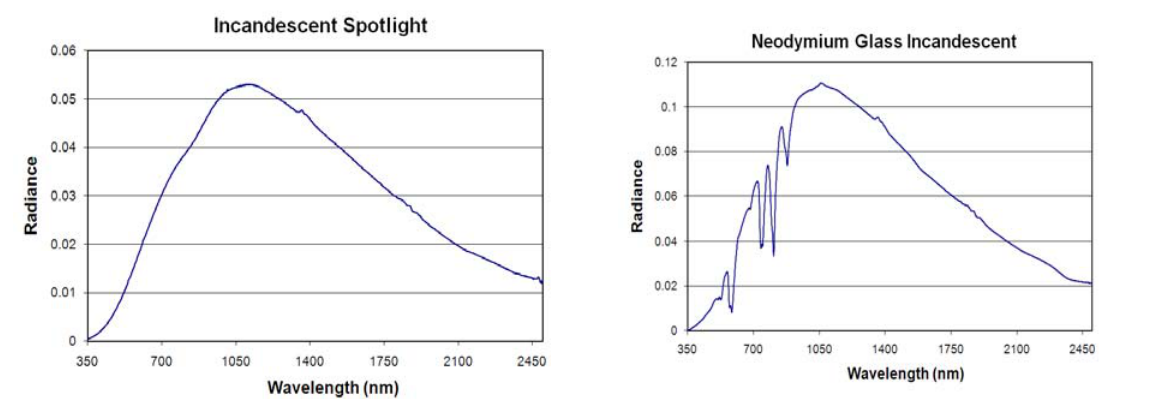
Figure 7. Emission spectra of incandescent lamps.